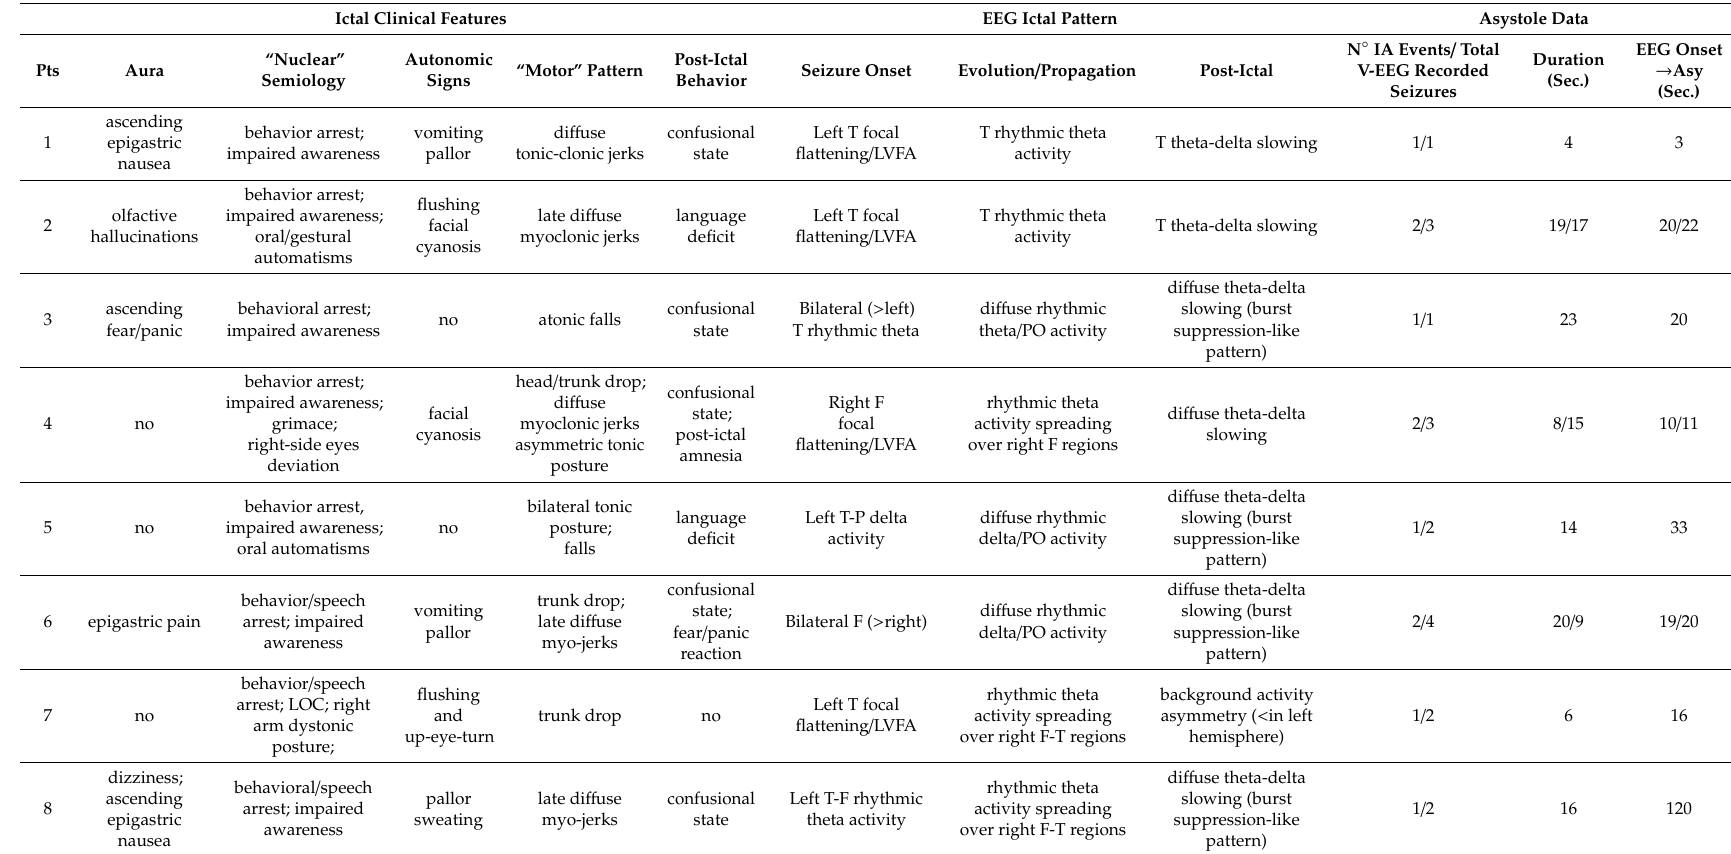
Table 2. Ictal electro-clinical data and asystole